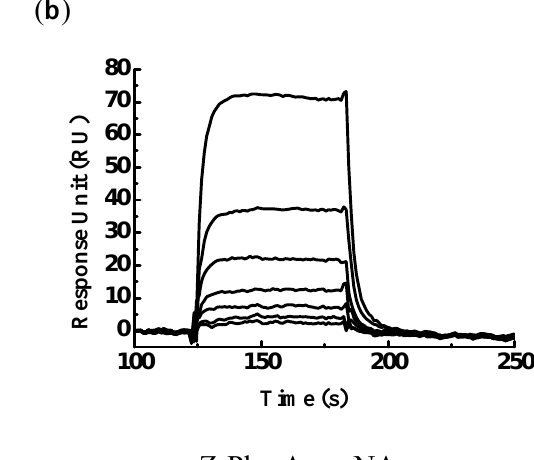
Figure 1. Sensorgrams for binding of compounds 1 (a) and Z-Phe-Arg-pNA (b) to a FP-2 surface on the CM5 sensor chip. Binding responses are shown for 1 and Z-Phe-Arg-pNA injected at concentrations of 0, 1.7, 2.4, 3.3, 4.9, 7 and 10 μ M (from bottom to